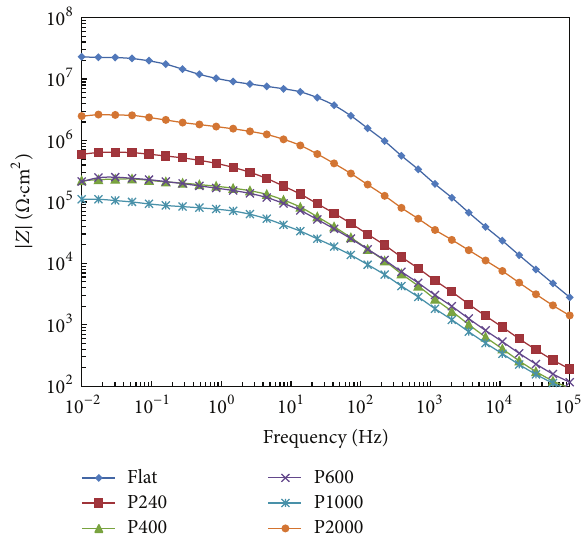
Figure 5: Bode plots from EIS measurements for flat and microstructured